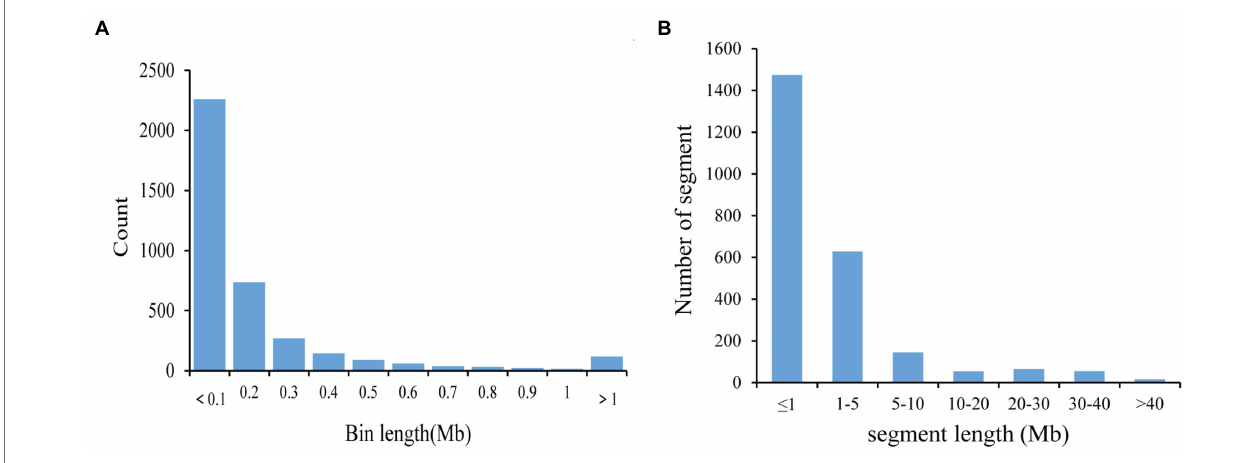
FIGURE 1 | Bin and introgressed fragments of CSSLs. (A) Distribution of the physical lengths of the bins. (B) Frequency of introgressed fragments according to length.